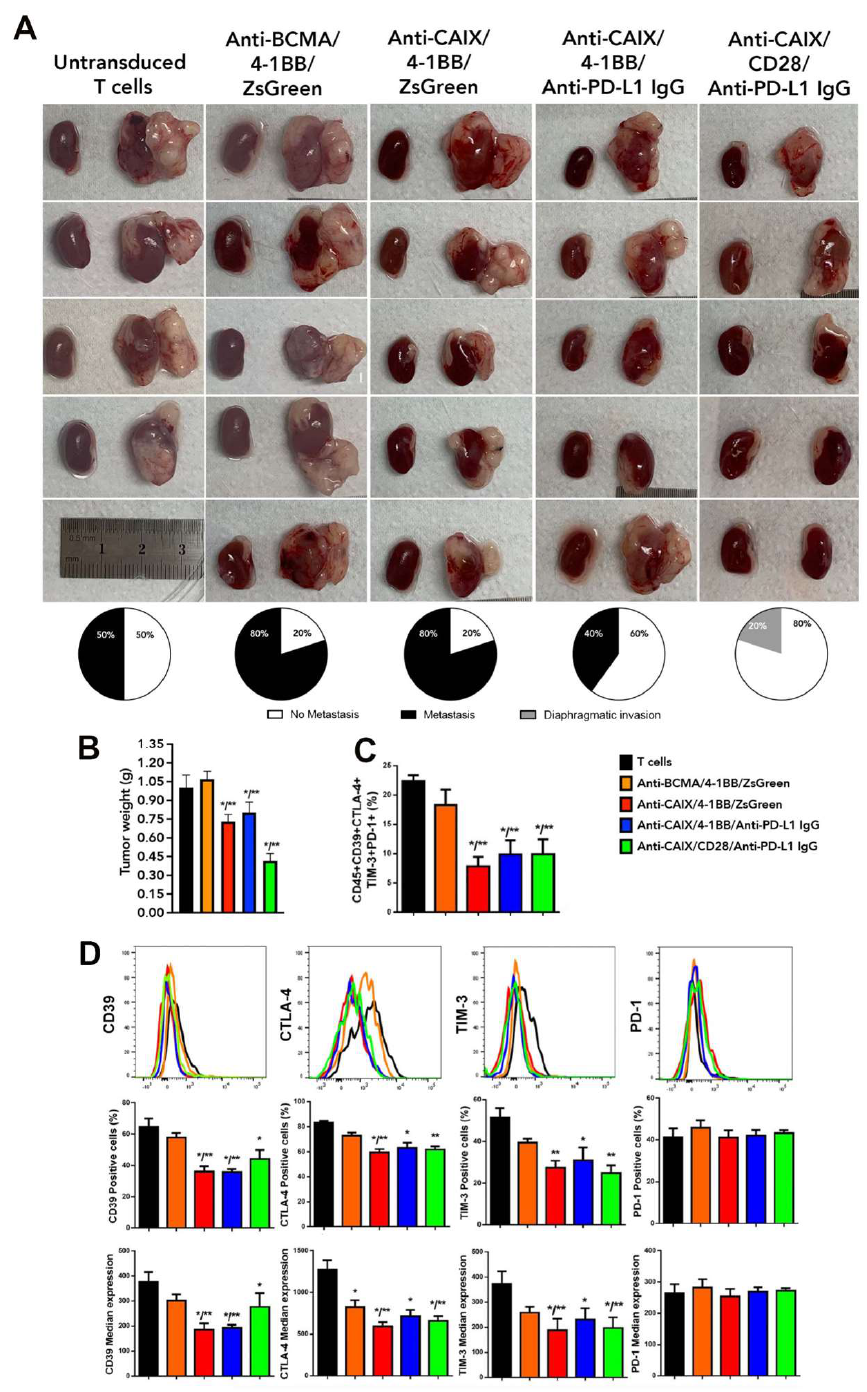
Figure 2. Comparative antitumor effect of anti-carbonic anhydrase IX (CAIX) chimeric antigen receptor (CAR) T cells CD28 ζ versus CD8 α 4-1BB ζ releasing anti-programmed cell death ligand-1 (PD-L1) IgG4 antibodies in an orthotopic model of human clear cell renal carcinoma (ccRCC). ( A ) Images of the kidneys with and without tumor of each of the mice treated with non-transduced T cells (T cells), anti-B cell maturation antigen (BCMA)/4-1BB/ZsGreen CAR T cells, anti-CAIX/4-1BB/ZsGreen CAR T cells, anti -CAIX/4-1BB/anti-PD-L1 IgG4 CAR T cells, and anti-CAIX/CD28/anti-PD-L1 IgG4 CAR T cells (N = 5/group) derived from three different donors (one or two mice were injected with CAR T cells from each donor inside a group) and the percentage of mice that presented metastasis (black) or localized invasion (gray) within each group, respectively. One mouse died after surgery,